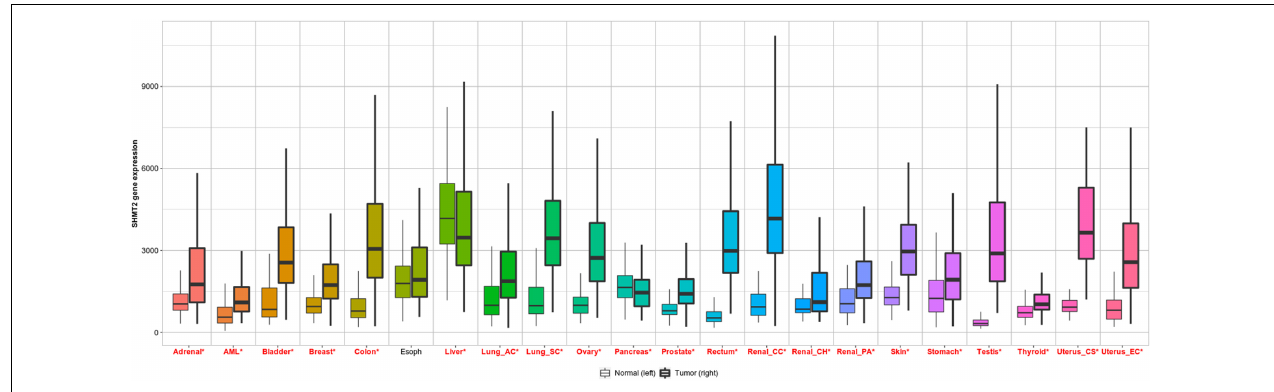
FIGURE 1 | SHMT2 expression in pan-cancer. Differential SHMT2 expression analysis in human tumors and normal tissues in TNMplot database. Significant differences are marked with red * P < 0.05 was recognized as statistically significant.